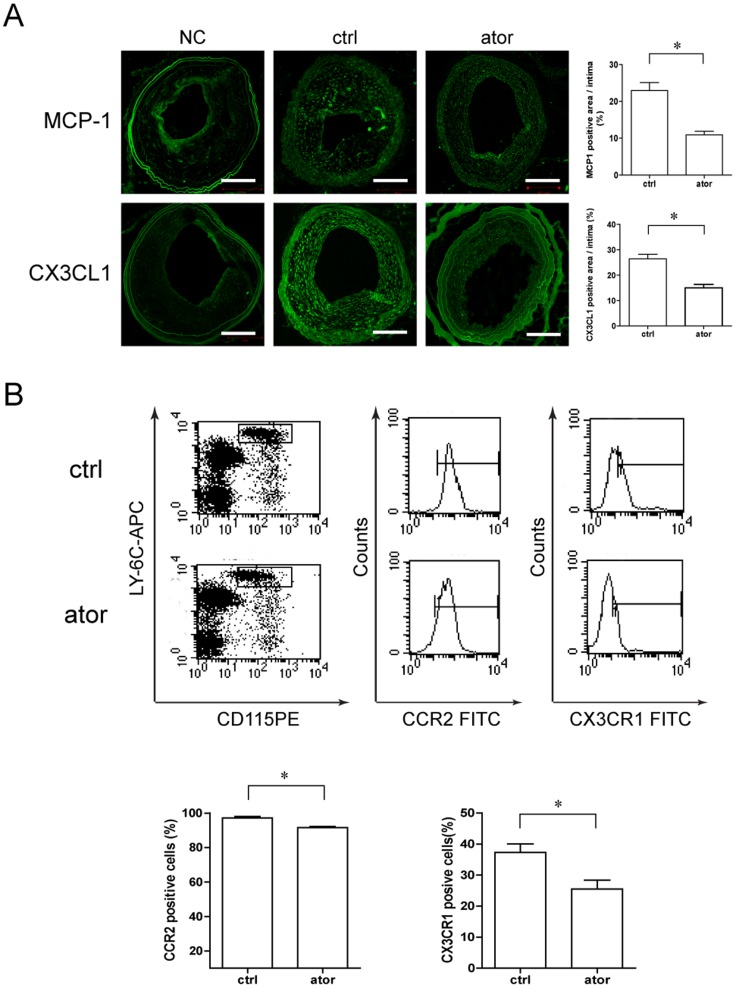
Effect of atorvastatin (10 mg/kg/d)on expression levels of intimal chemokines and their receptors e on peripheral blood monocytes in ApoE-/- mice.(A) Representative images of immunostaining for MCP-1 and CX3CL1 (scale bar  = 100 µm) and quantification in the control and atorvastatin-treated groups (*p<0.05, n = 6). (B) Representative FACS analysis for monocytes with double-immunofluorescent labeling for CCR2 and CX3CR1. Data represent the mean ± SEM of the percentage of marker-positive cells from six experiments. *p<0.05 compared with control.